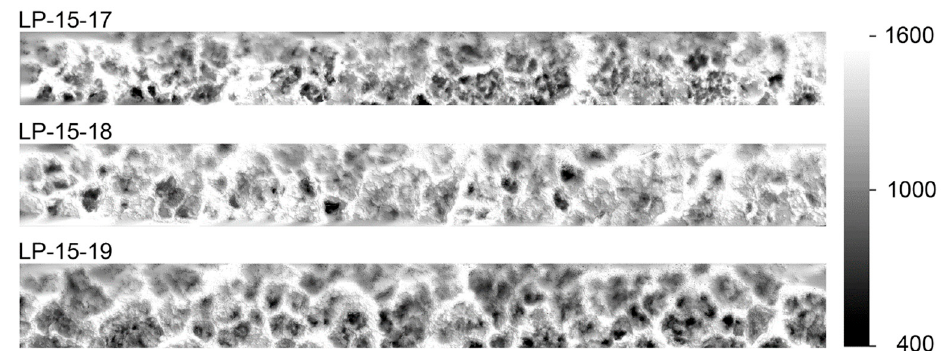
Figure 6. DEMs of LP-15-17, LP-15-18, and LP-15-19. The cell of honeycomb polygonal uplifts in LP-